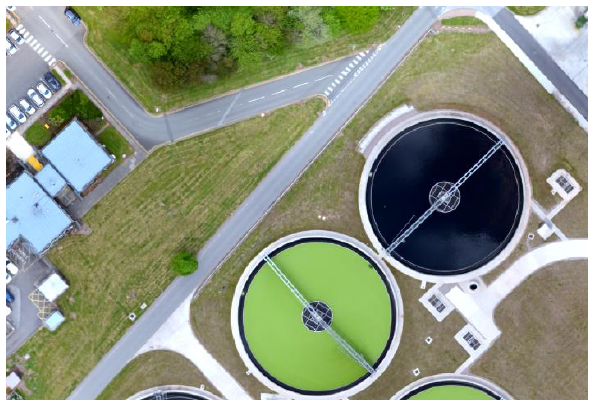
Figure 5. A view of the new features in the Strongford sewage treatment works, captured by the PrecisionHawk